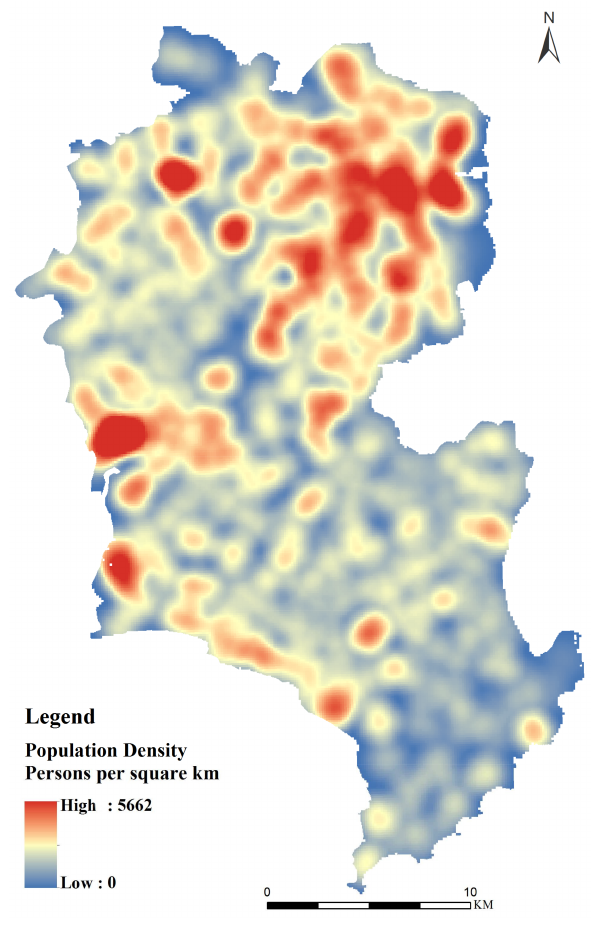
Figure 3. The spatial distribution of population density in 2014 (mapped using kernel density in Arc GIS